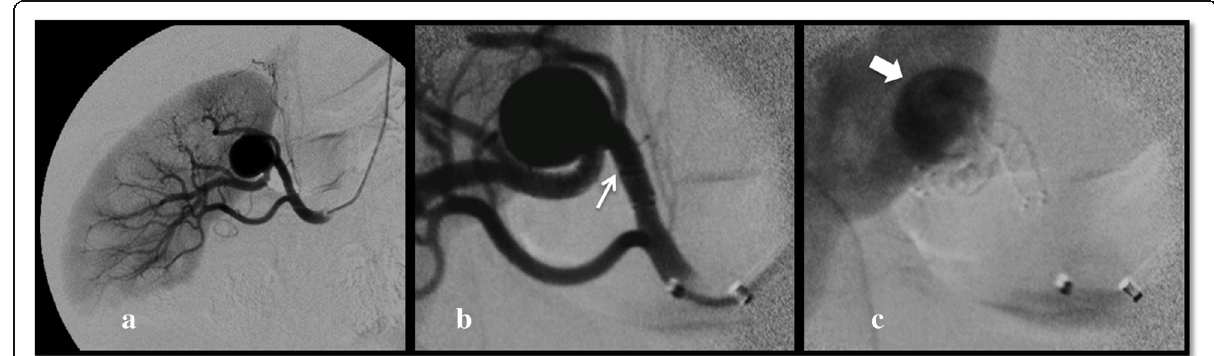
Fig. 1 a , b , c (Patient 1) Transhumeral digital subtraction angiography of the right renal artery confirms the presence of a segmental branch VAA ( a ). Postoperative subtracted view immediately after the deployment of a Fred 4/32/26mm (arrow) showing patency of the stent ( b ) and early stagnation (large arrow) of contrast media into the aneurysm sac ( c